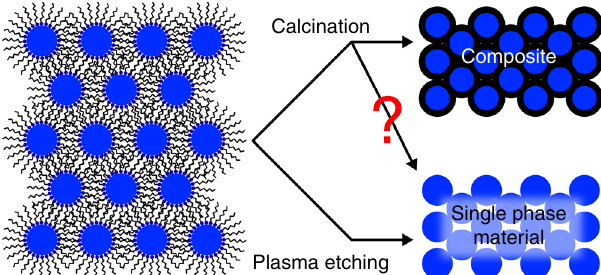
Fig. 1 Difference between calcination and plasma processing. Schematic of the resulting microstructure after the ligand removal in colloidal nanoparticle assemblies (CNAs) by calcination and plasma